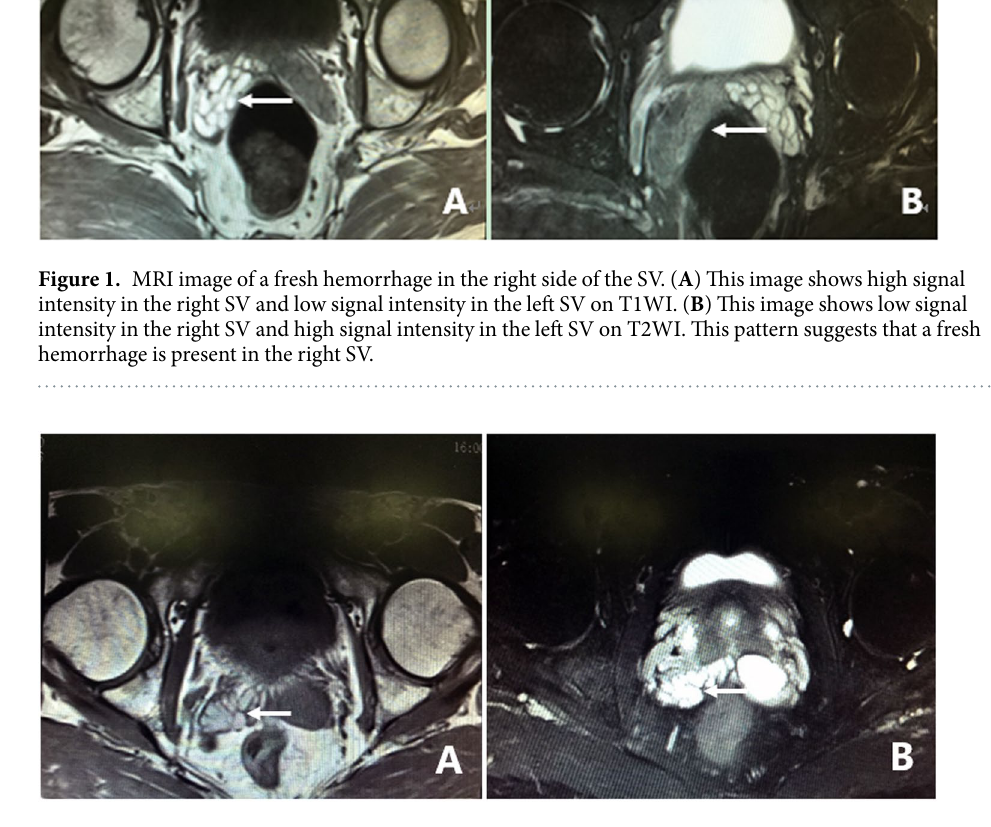
lesions in the ED area, which were present in 36.7% (112/305) patients, with or without differences in internal signal intensity or dilatation of the SV. The cystic lesions are divided into the following four categories. Of the 36.7% (112/305) patients, 31.5% (96/305) of the patients had cysts located in the medial region of the veru- montanum, of which 25.6% (78/305) of the cases were prostatic utricular cysts (PUC) with sizes ranging from 0.6 × 0.7 cm to 2.0 × 2.3 cm, which was mostly confined to the prostate gland (Fig. 3), and 5.9% (18/305) of the cases were Müllerian duct cysts (MDC) with sizes ranging from 3.4 × 4.5 cm to 8.8 × 11.5 cm, which was usually larger than PUC and beyond the range of the posterosuperior margin of the prostate (Fig. 4), respectively, all of which were confirmed by seminal vesiculoscopy. ED cysts (EDC), a rare type of cyst, were observed in only 1.6% (5/305) of the patients (3 on the left side, 2 on the right side), which communicates with the urethra and one side of the SV. SV cysts (SVC), which the normal typical honeycomb-like and small tubular structure within SV was replaced by single cavity of enlarged cystic structures with smooth edges and clear boundaries, were observed in 3.6% (11/305) of the patients (Fig. 5). The signal intensity of cysts may be normal or abnormal. Among the 36.7% (112/305) cases of cysts in the ED area, 20.3% (62/305) were accompanied by hemorrhages in the cysts or SV, of which 15 were fresh and 47 were old. (3) The third common feature was the changes in size and morphology in the unilateral or bilateral SV, which presented in 32.1% (98/305) of the patients (Fig. 6). The width of the SV more than 1.7 cm or diameter of the inner tubular structure larger than 5 mm was presumed to be indicative of enlarge- ment or dilatation according to our previous study 5 . These differences in morphology or size in the 98 patients were present in unilateral or bilateral SV, with or without internal signal intensity changes, and the average width of the SV was 2.15 ± 0.36 cm. The changes were confirmed to be due to incomplete or complete EDO on the corre- sponding side by transurethral observation. (4) The fourth sign was stone formation in SV or in an adjacent cyst, which was present in 8.5% (26/305) of the patients. Such stones are most common in SV or prostatic utricle (PU). Some patients showed more than one abnormal sign. There were 13.8% (42/305) of patients whose pelvic MRI images presented no significant abnormalities in the SV area relative to the normal pelvic MRI images.